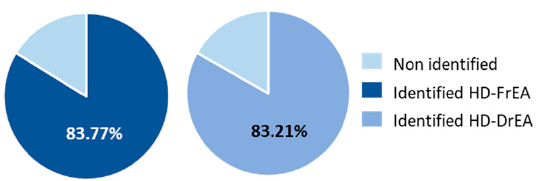
Figure 7. Diagram showing the portion of identified compounds in the hydrodistillate of E. amentacea . HD-FrCC—hydrodistillate of fresh E. amentacea ; HD-DrCC—hydrodistillate of air-dried E. amentacea . The content of unsaturated aliphatic compounds (27.55%) in HD-FrEA was slightly greater than the content of saturated aliphatic compounds (26.41%). They both decreased after air drying (2 times, unsaturated; 1.2 times, saturated) (Figure 8). ( E )-Hex-2-enal was the most abundant among the group of unsaturated aliphatic compounds, with an area percentage of 13.16% in the fresh sample, and was detected in traces in the dry samples. Among the group of saturated aliphatic compounds, pentadecane, heptadecane, pentade- canal, and hexan-1-ol were predominant in terms of abundance in HD-FrEA (Table 4). Their area percentage decreased in